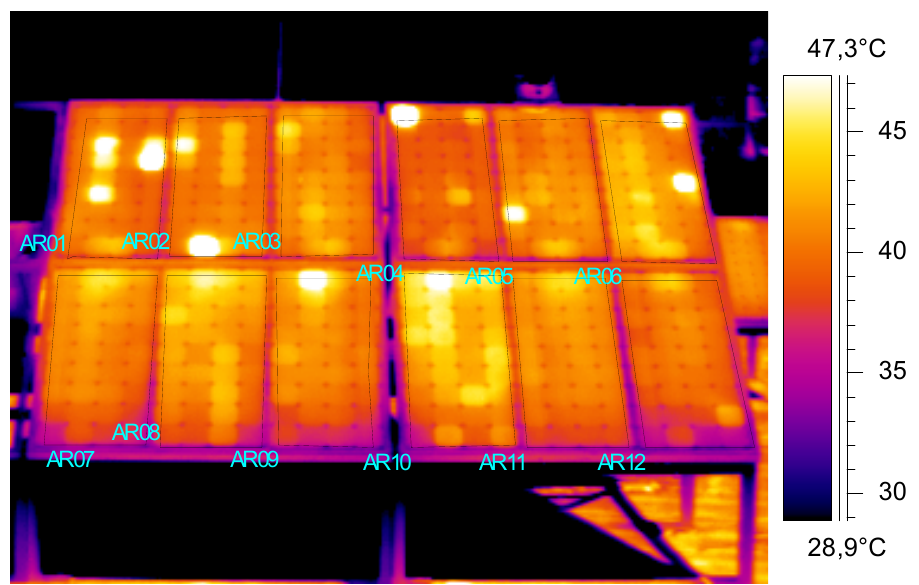
Figure 8. Example of an IR image of the investigated panels.